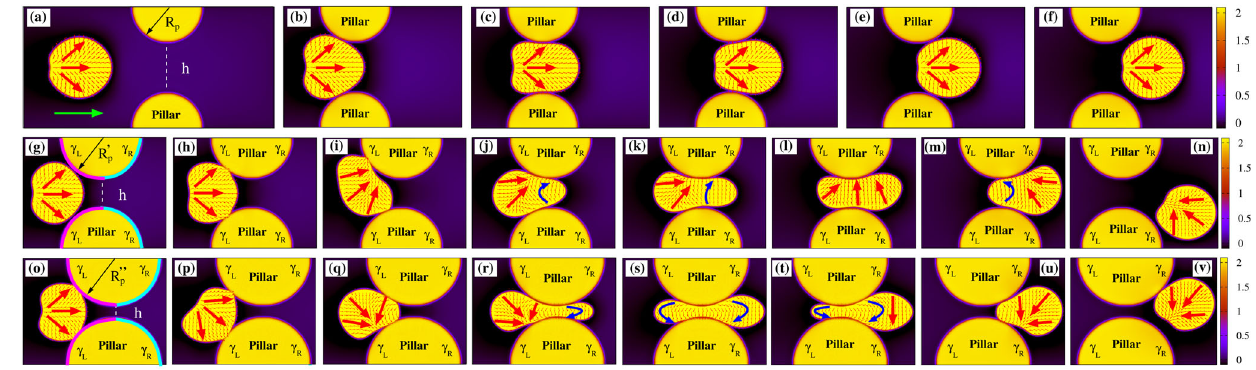
Fig. 2 | Transmigration ofan active drop across a constriction. a – f If the size of motion, exhibiting a temporary bend deformation (highlighted with blue arrows), the constriction is comparable with that of the droplet ( λ ≃ 0.8, h =72, R p =49, initially at the front ( j and k ) and then shifted towards the back ( m ). At the exit of D =90), the latter moves unidirectionally (the green arrow indicates the direction the pore, the droplet detaches from the pillars and proceeds along the direction of motion) undergoing weak shape deformations, such as a slight longitudinal imposed bythe splay deformation ( n ). o and v If the sizeof the constriction isvery stretching ( b ) and mild compression ( c and d ).Out of the constriction, the circular narrow ( λ ≃ 0.2, h =20, R 00 p =75, D =90), the droplet initially adheres to the pillars and then shifts downwards to protrude its leading edge within the pore ( o – q shapeisrestored( e and f ).Thesplaydistortion(highlightedbylargeredarrows)of the polarization remains essentially unaltered. g – n If λ ≃ 0.5 ( h =46, R 0 p =62, D =90), the incipient unidirectionalmotion slows down as the droplet approaches the constriction, where large portions of the fl uid interface stick to ( g and h ) because of adhesion forces, larger at the entry and weaker at the exit (here − 2 , γ − 3 ).Afterwards,thedropletundergoesanintensefolding( i ) γ L =3×10 R =7.5×10 followed by a signi fi cant elongation ( j – l ) and decompression ( m ). Within the con- striction, the polarization aligns essentially perpendicularly to the direction of